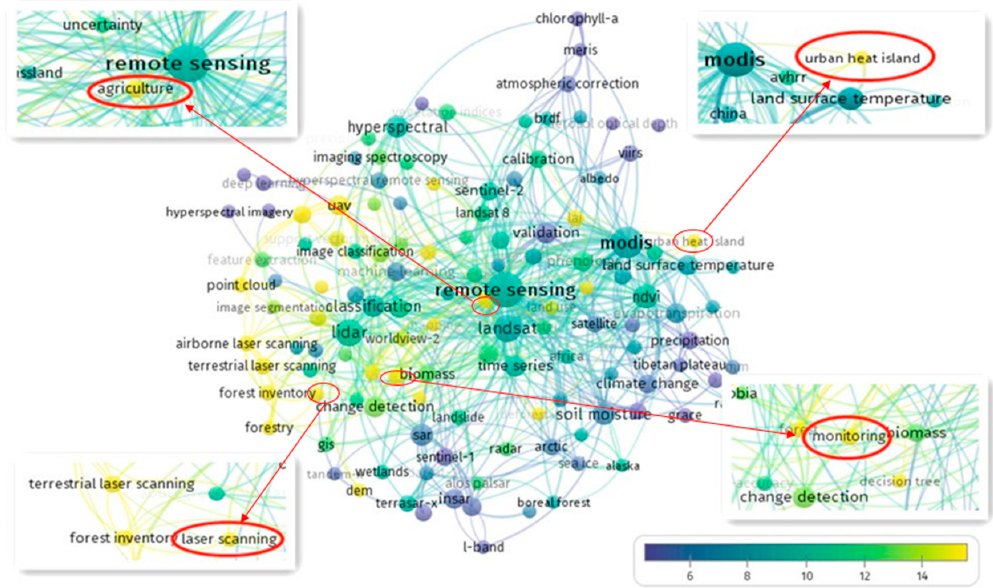
Figure 8. Mapping the citation impact of remote sensing research topics as determined based on the keywords in the publications.